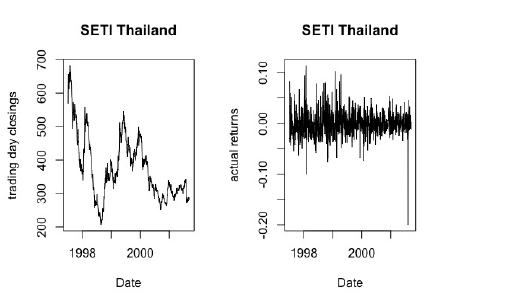
Figure 6. Plots of trading days closings and actual returns of SETI and SP500.